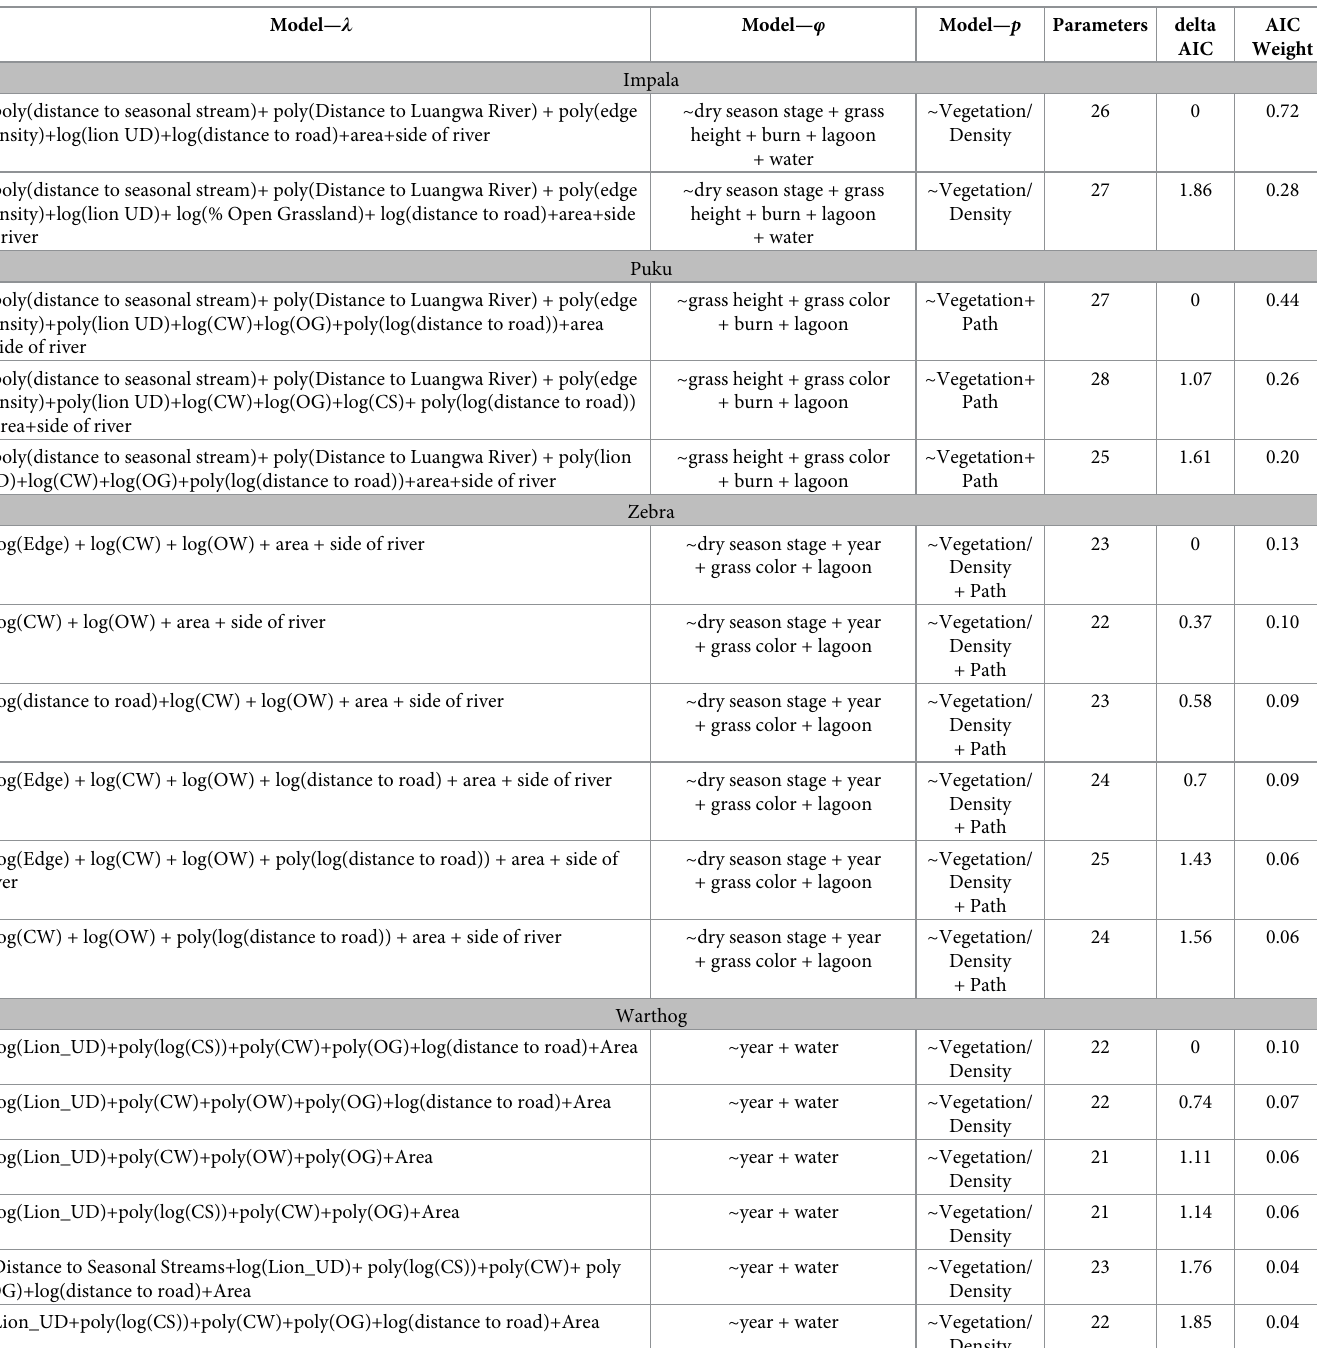
Table 3. Model selection results for distance sampling models estimating group density for the focal herbivore species. Model-averaged predictions were made using models within 1 delta AIC score of the top model; top models were used if there were no closely-competing models. Continuous covariates may appear in models as a lin- ear, logarithmic (log), or 2 nd -order polynomial (poly) association with the